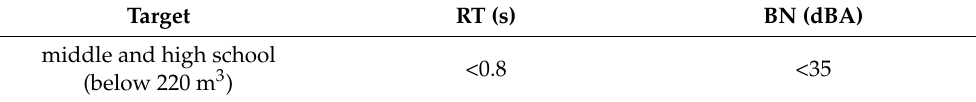
Table 3. Suggested acoustic performance standards for classrooms in Korea